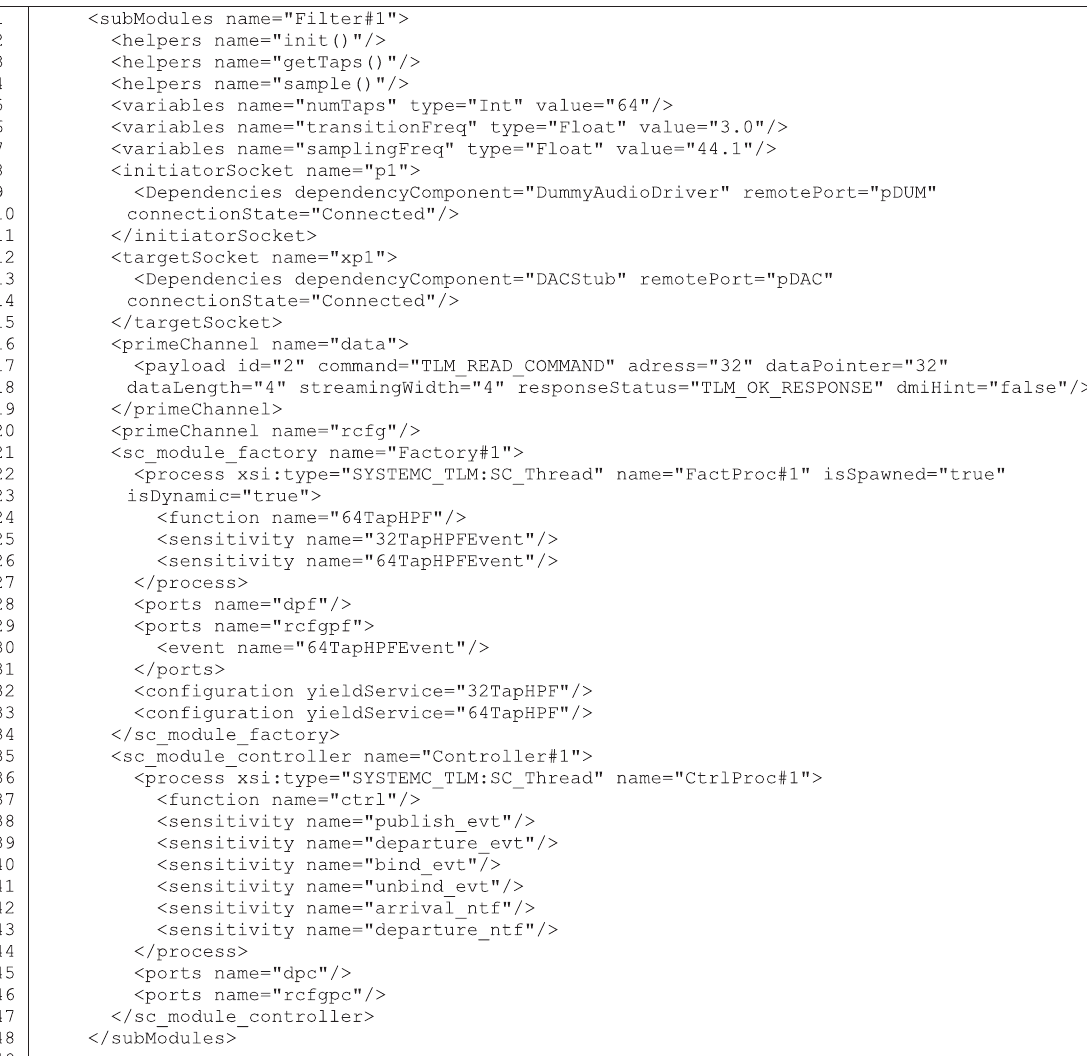
Figure 28: A part of the generated SCTLM XMI Model (a